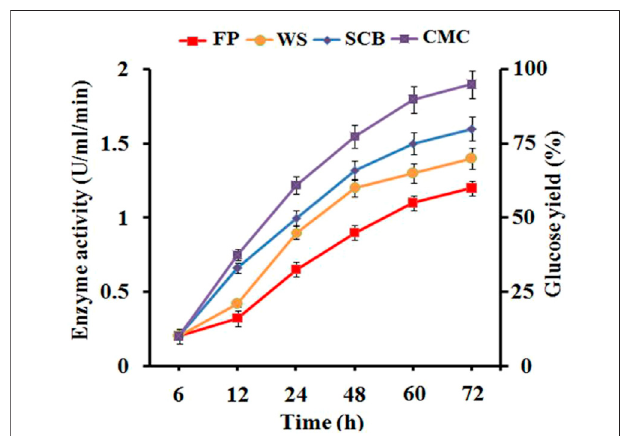
FIGURE 1 | Cellulase production was measured in terms of CMCase activity in the culture supernatants during the addition of different carbon sources (CMC, SCB, WS, and FP) to the culture medium and the percentage of glucose released from these substrates upon crude cellulase treatment at distinct